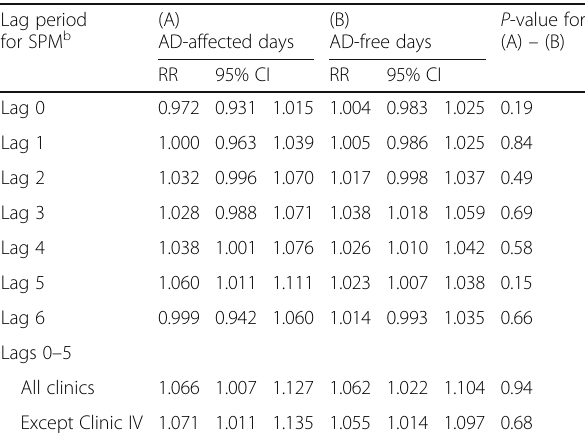
AD Asian Dust, SPM suspended particulate matter, RR relative risk, CI confidence interval a Using single-lag model with adjustment for the day of the week, public holidays, month, year, the natural cubic splines of daily mean temperature, relative humidity and pollen (lag 0 – 5) with 3° of freedom. An interaction term between SPM and pollen concentration was included. Refer to Additional file 2: Table S2 for further information b Delayed effects longer than 1 day were constrained as